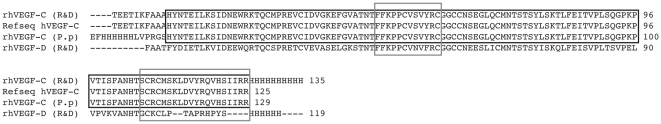
Amino acid sequences of ΔNΔC-VEGF-C and ΔNΔC-VEGF-D variants used in the study.The region of 100% identity within used ΔNΔC-VEGF-C variants is shown within the black frame, the possible epitope regions of VC2.2.2 anti-VEGF-C scFv on ΔNΔC-VEGF-C and the corresponding regions on ΔNΔC-VEGF-D are shown within grey frames. P.p, P. pastoris-derived ΔNΔC-VEGF-C; R&D, commercially available mammalian cell-derived ΔNΔC-VEGF-C or ΔNΔC-VEGF-D, respectively.